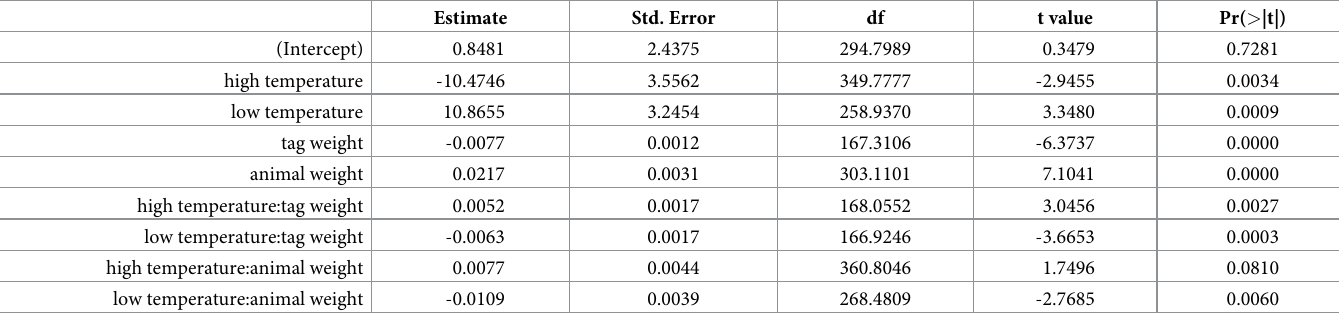
Table 6. Mixed linear model of the distance travelled ( movementSum ) by crickets over 3 days.